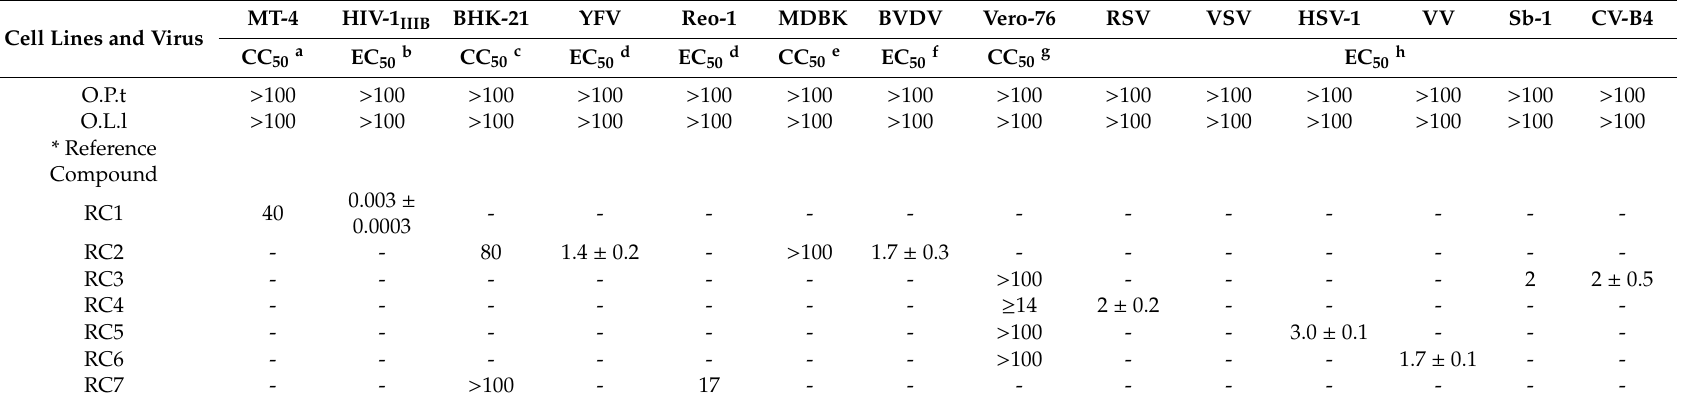
Data represent mean values + standard deviation (SD) for three independent determinations. For values where SD is not shown, variation among duplicate samples was less than 15%. O.P.t: essential oil from the leaves of Paramignya trimera; O.L.l: essential oil from the leaves of Limnocitrus littoralis ; RC1: Efavirenz; RC2: 2 (cid:48) -C-methylguanosine; RC3: Pleconaril;